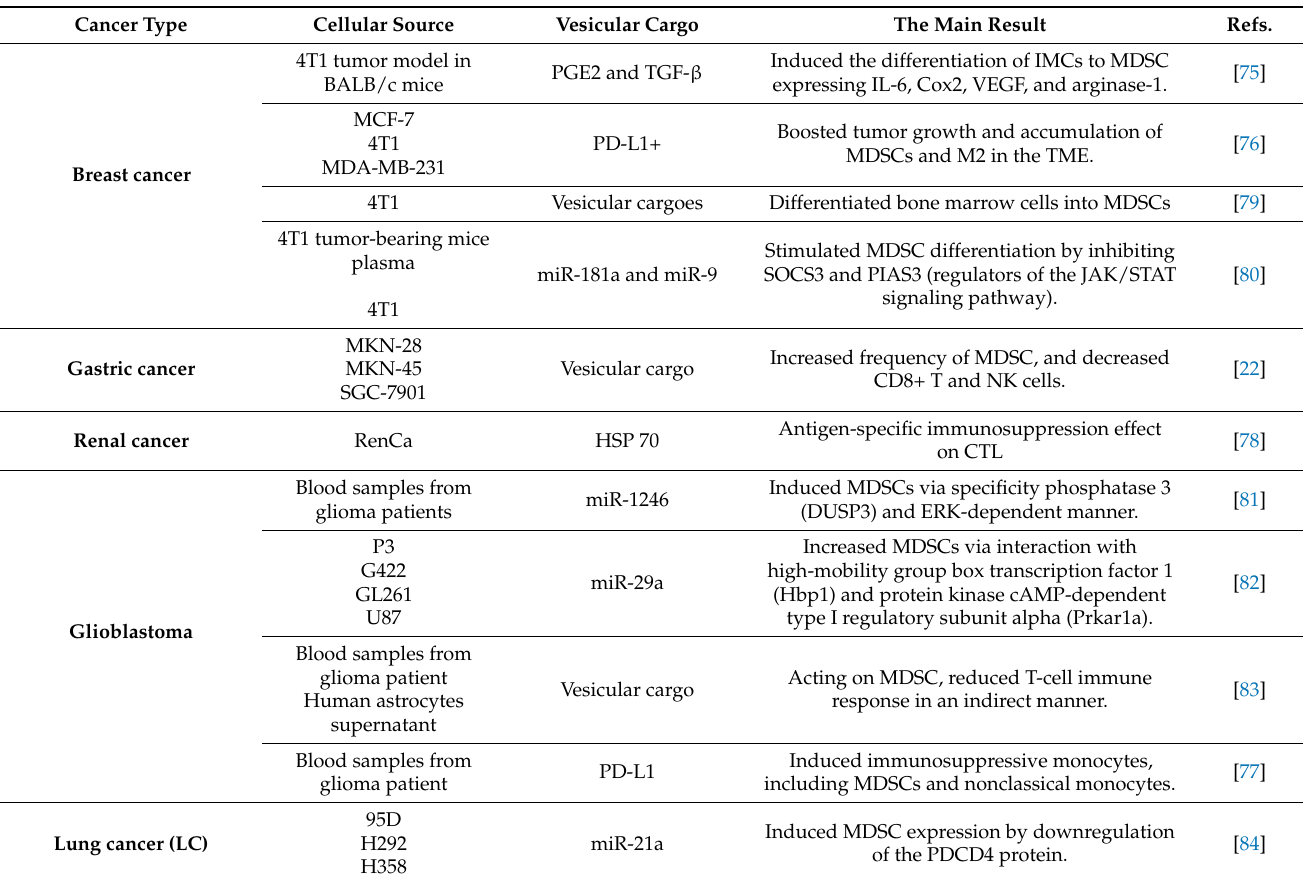
Table 3. Effect of TEVs on immature myeloid cell differentiation to MDSC in the TME. Vesicular Cargo The Main Result